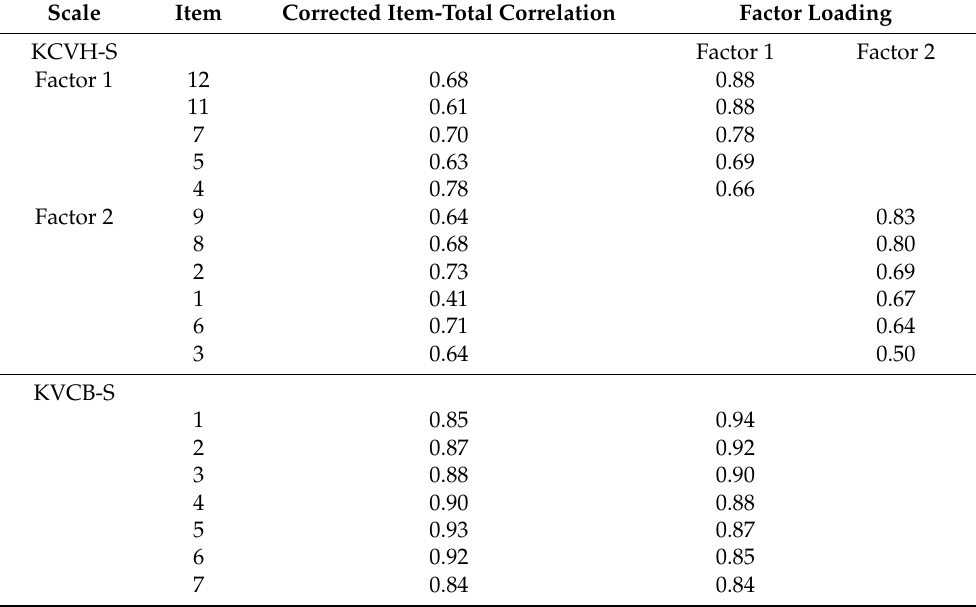
Table 2. Corrected item-total correlation and factor loadings in exploratory factor analysis using data set A. Scale Item Corrected Item-Total Correlation Factor